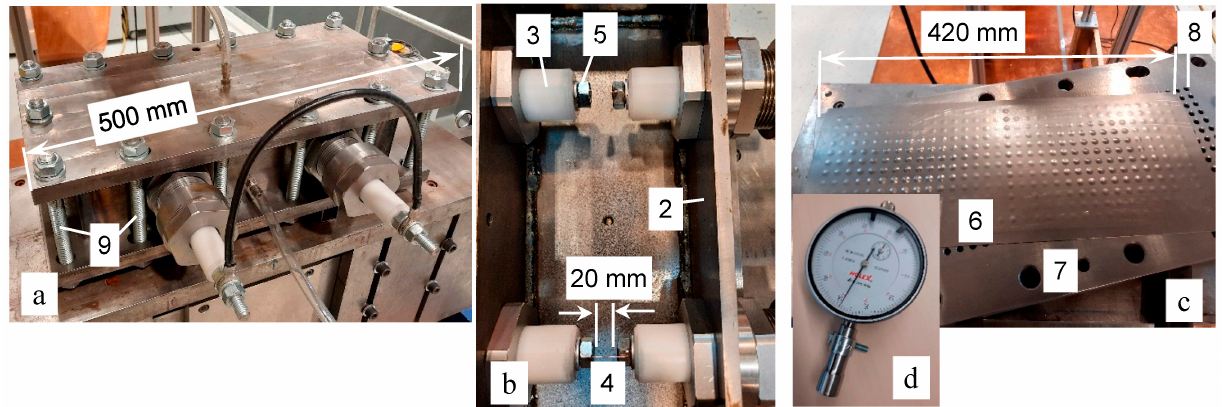
Figure 2. General view of the experimental tooling ( a ), discharge chamber with electrodes and wire fixation ( b ), multipoint pressure gauge body and metallic membrane after impulse loading ( c ), dial indicator with adaptor for 6 mm dimples ( d ); Numbering is the same as in Figure 1.